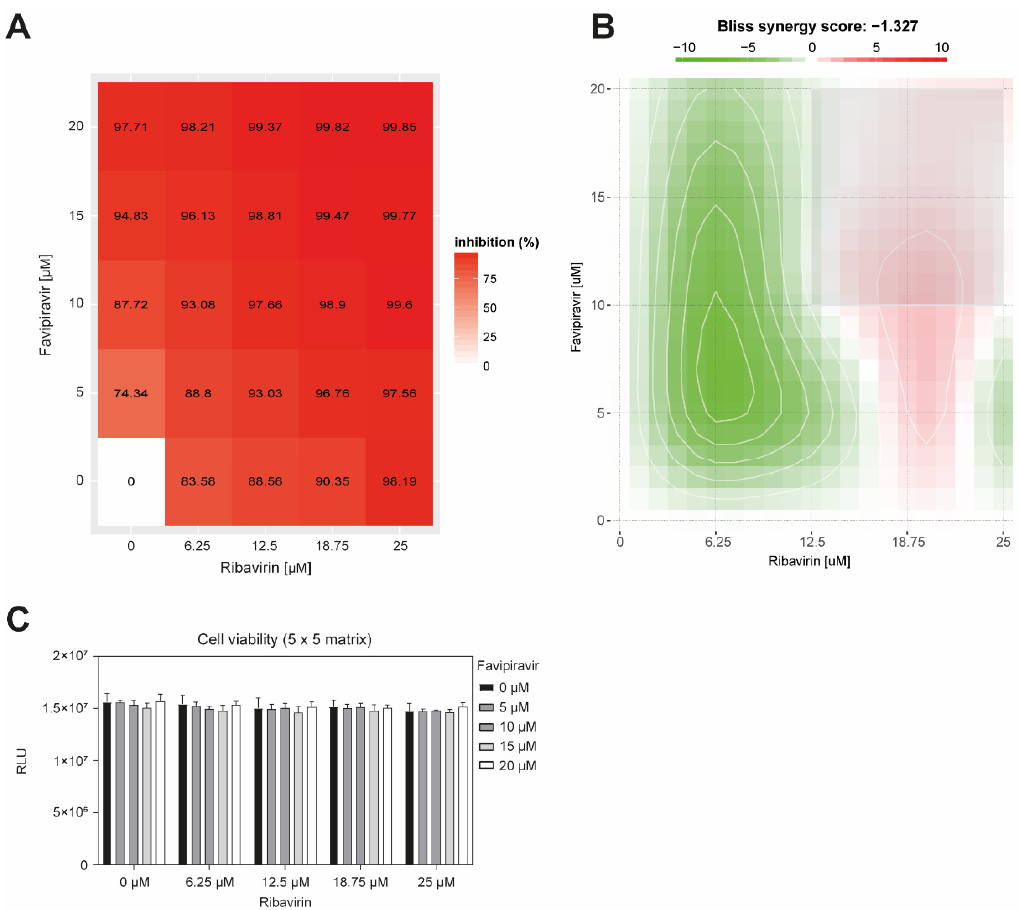
Figure 2. Additive effects of ribavirin with T-705. Vero E6 cells were pre-treated with a 5 × 5 compound combination matrix prior to infection with HTNV. At 5 dpi, the viral titer on the cell supernatant was determined by RT-qPCR. The compound combinations evaluated were ribavirin and T-705. ( A ) Dose-response matrix of favipiravir/ribavirin combinations. The values reported are expressed in percentage of virus production inhibition. Infection levels were assessed by RT-qPCR. Data are means of triplicate experiments. ( B ) Bliss synergy map. Color scale bar indicate mode and strength of interaction. Antagonism: less than − 10; additive: from − 10 to 10; synergism: larger than 10. Data are means of three independent experiments. ( C ) Cell viability over 5 days. Monolayers of Vero E6 cells were treated with the indicated concentration of ribavirin and/or favipiravir under the assay conditions and viability was measured by the Cell-Titer Glo ® assay. Data are means + SD (n = 3) of relative light units (RLU).